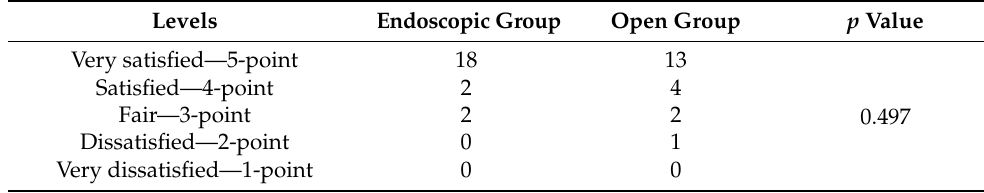
Table 5. Satisfaction with the surgical outcomes of the two groups at the last